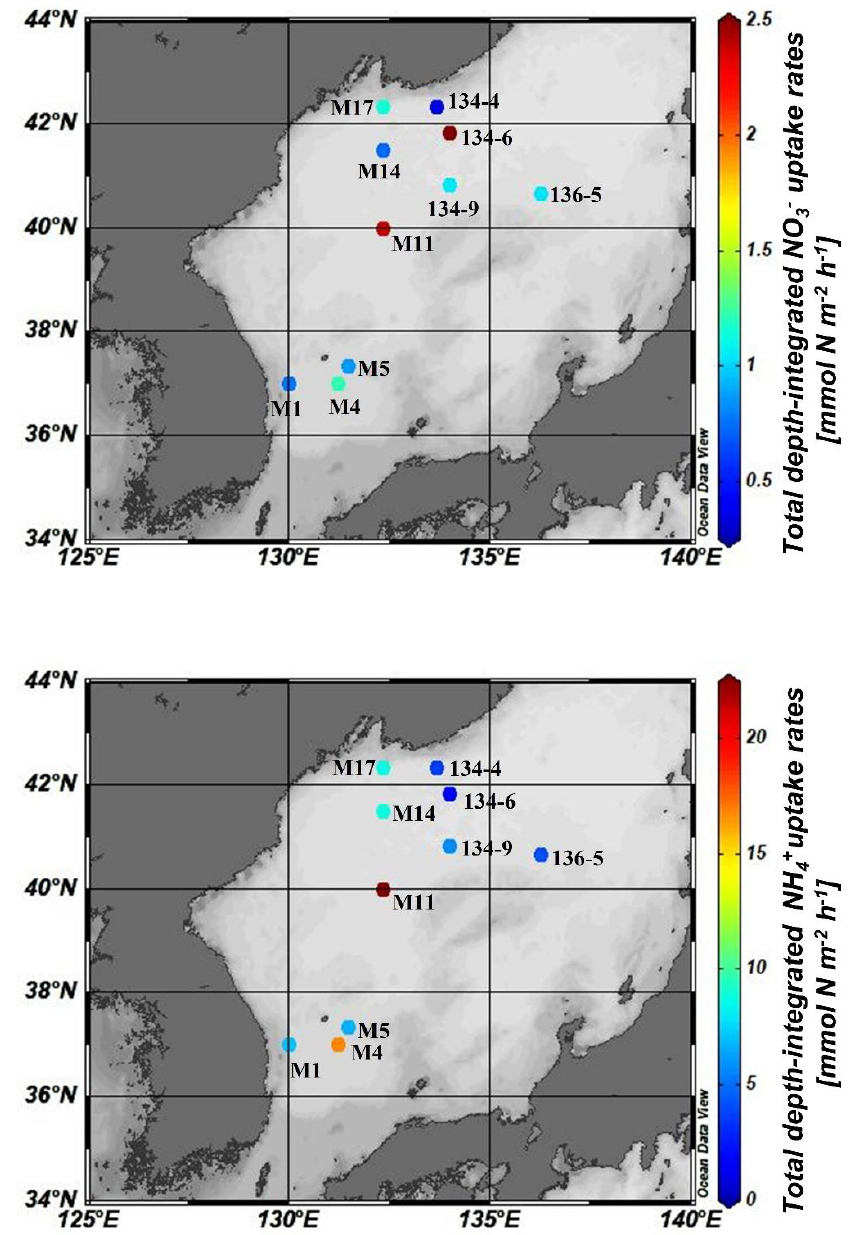
Figure 5. Depth integrated total NO 3− and NH 4+ uptake rates in the East/Japan Sea during 2012.